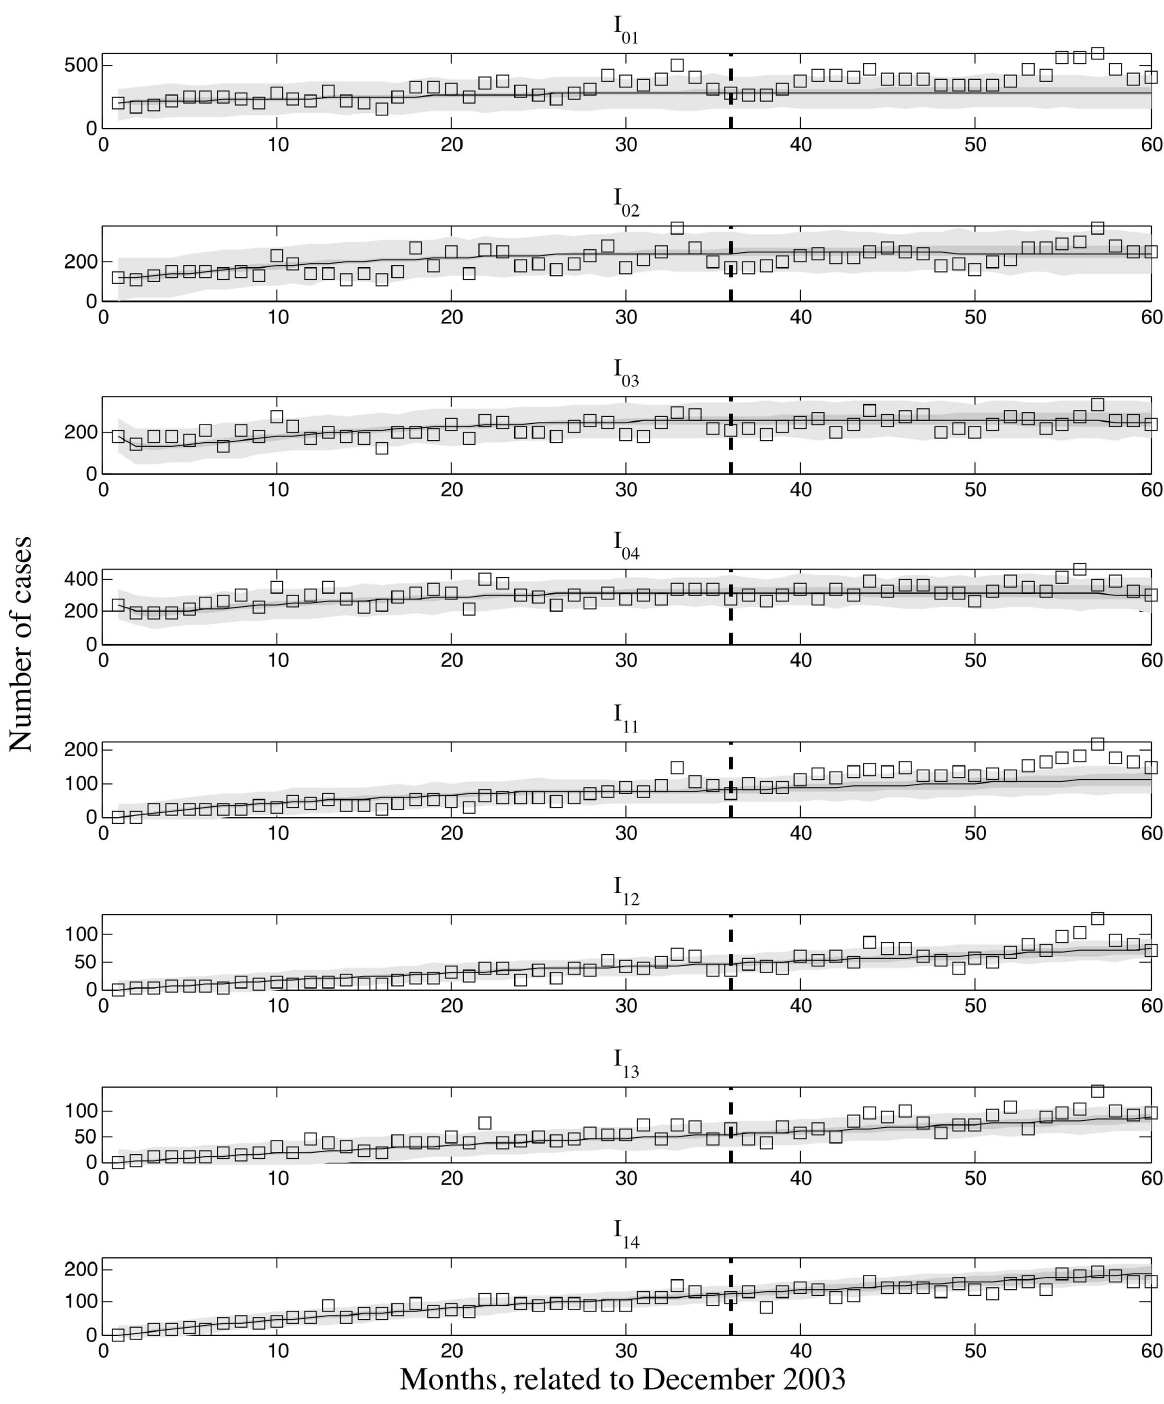
Figure 3. Model fit to MRSA infection data using MCMC toolbox. The wider band shows 95% probability limits for individual observations, the darker narrower band shows 95% probability limit for mean prediction and the black curve in the middle is the median prediction. Little squares are data points; the vertical dashed line indicates the calibration period (2004–2006) and the validation period (2007–2008). which showed no monotonic relation with R c (not shown in individuals across all age groups were treated by decolonization Figure 5B1). The mean R c decreased by 2.1% when all infected drugs (Figure 5B3). We found that decolonization treatment individuals aged 10–14 yrs were treated by decolonization drugs strategies targeting symptomatic infected individuals were not for regular antibiotic treatment for CA-MRSA infections sufficient to achieve disease control. Simulations of decolonization (Figure 5B2) while R c was reduced by 7.8% when all infected treatment strategies targeting all infected individuals in pediatric